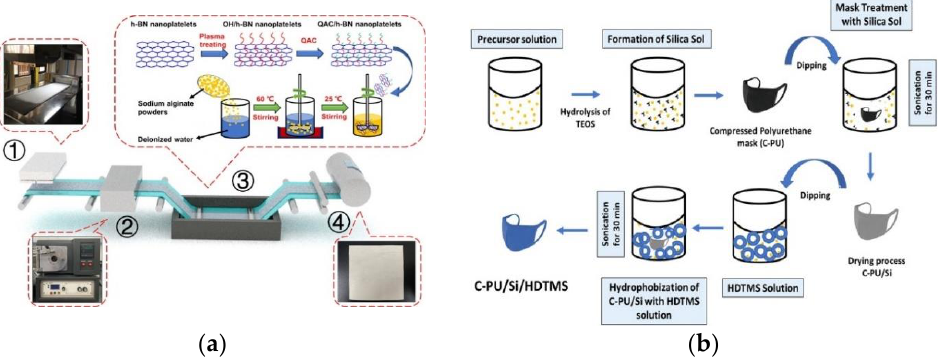
Figure 2. ( a ) Scheme of the preparation process of the QAC/h-BN/PP nanocomposite fibrous membranes. The preparation process includes four steps as follows: (1) preparation of PP ultrafine fiber nonwovens by melt-blown processing with high-speed and high-temperature hot wind. (2) Treatment of the meltblown PP ultrafine fiber nonwovens with oxygen plasma to activate their